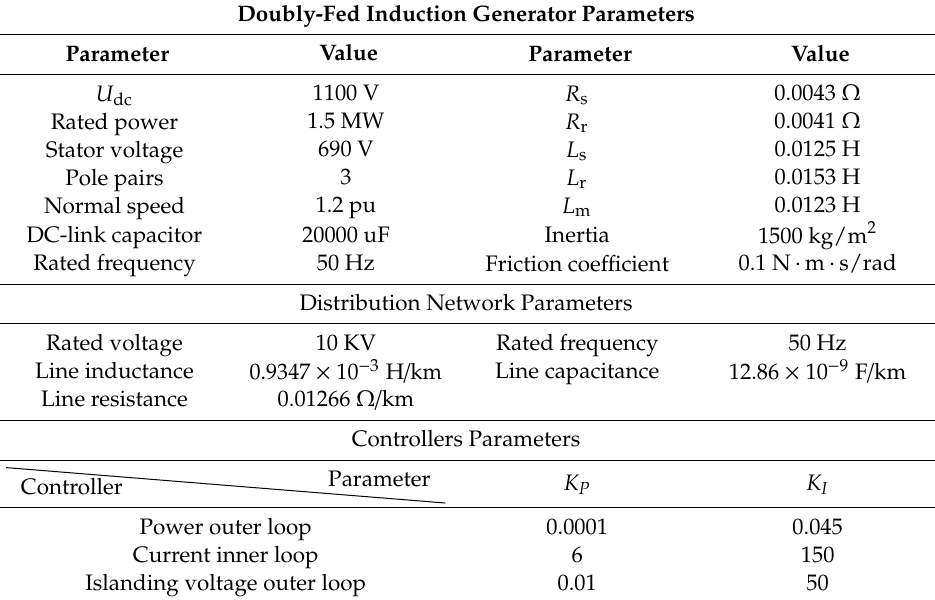
Table A1. Simulation parameters of case